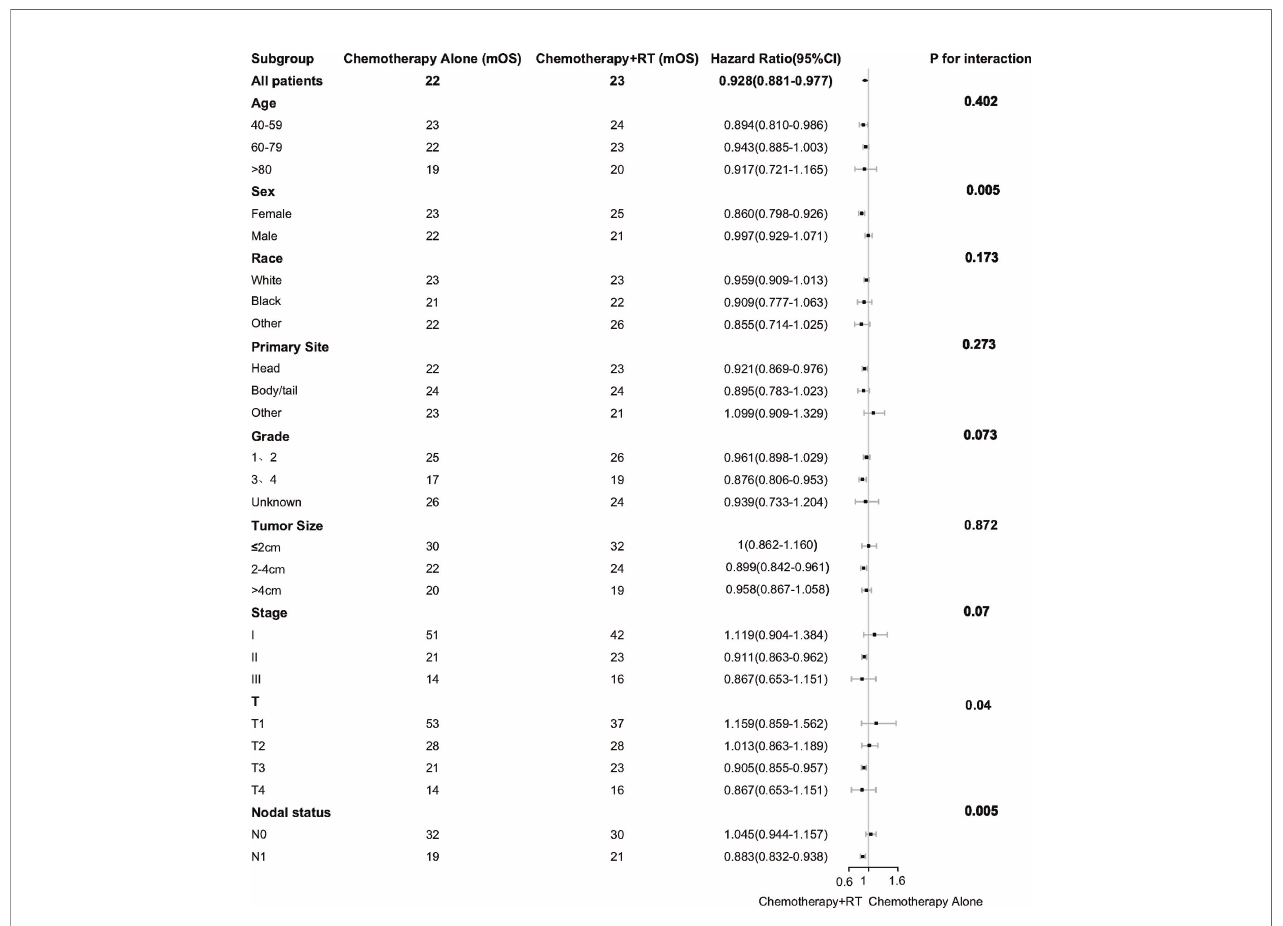
FIGURE 2 | Adjusted overall survival impact of chemotherapy and chemoradiotherapy among subgroups. RT indicates